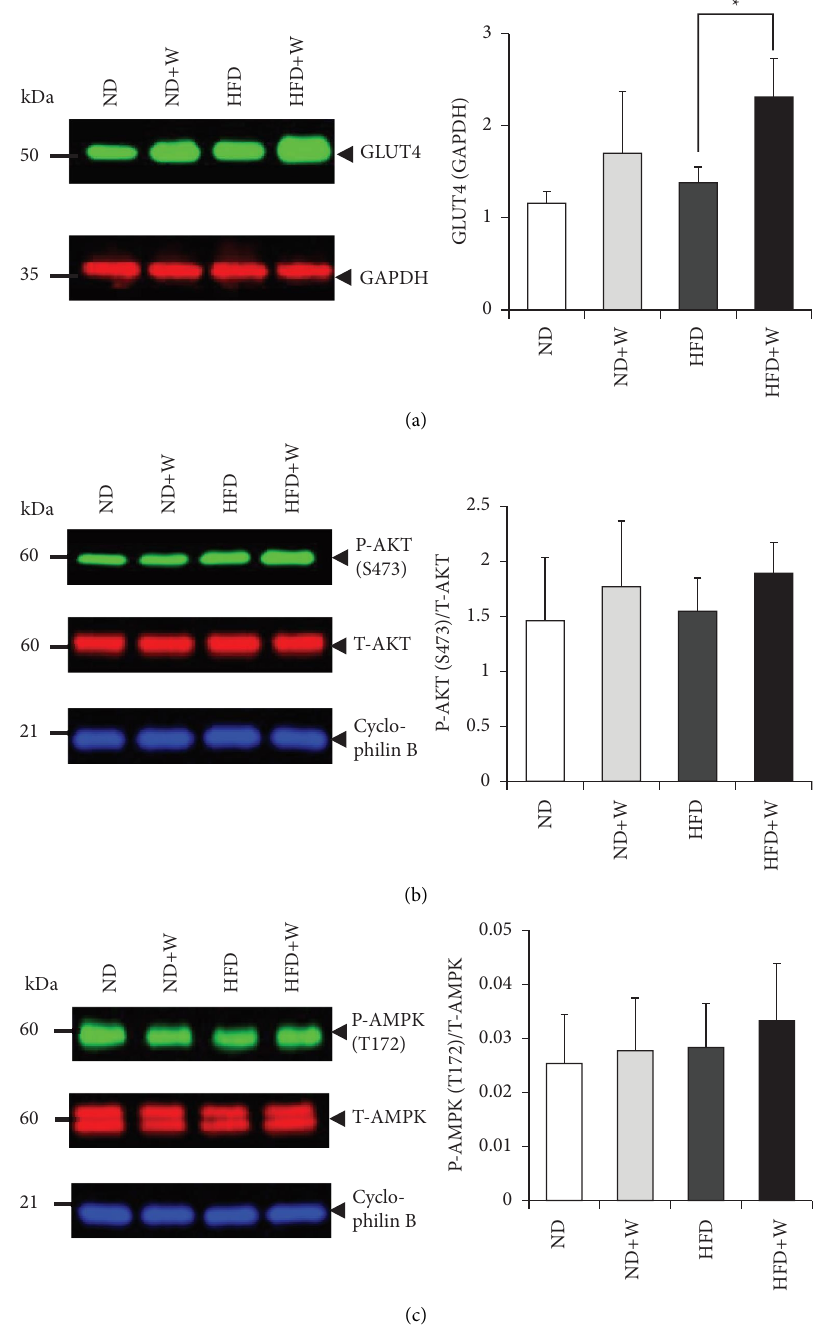
Figure 6: Wakame’s efect on level and phosphorylation of insulin signaling molecules and GLUT4 in skeletal muscle. Te skeletal muscle cells were collected via dissection from the ND, ND+W, HFD, and HFD+W mice. Te cell lysates were analyzed by Western blotting with (a) GLUT4, (b) P-AKT (s473) and T-AKT, and (c) P-AMPK (T172) and T-AMPK antibodies. Te level of GLUT4 was normalized to that of GAPDH. Te level of P-AKTand T-AMPK was normalized to that of their respective total protein. Te data were presented as mean ± SD ( n � 4-5) and analyzed with one-way ANOVA combined with the Tukey test. ∗ p < 0 .